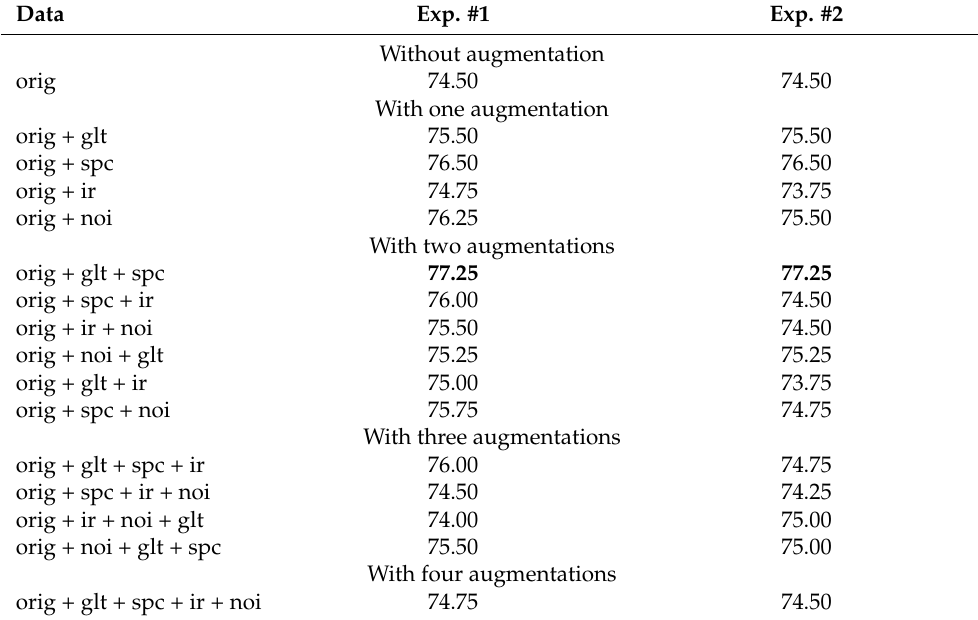
Table 4. Unweighted average recall (UAR, %) of SER with different data augmentation techniques on JTES-STI . orig = original JTES dataset, glt = glottal source extraction, spc = speech cleaned, ir = impulse response, noi = noise addition. The highest scores for each experiment are in bold.